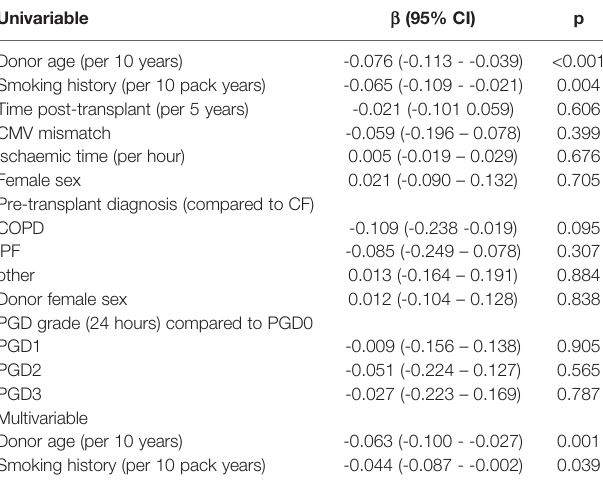
TABLE 3 | Factors associated with bronchial telomere length (n =